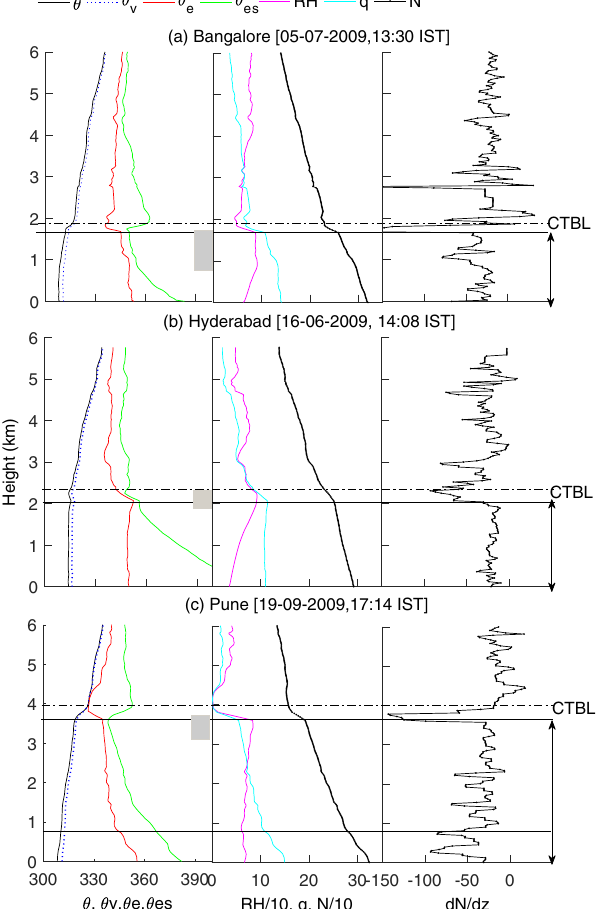
Figure 7. Same as Fig. 4 but observed over (a) Bangalore on 5 July 2009, (b) Hyderabad on 16 June 2009, and (c) Pune on 19 September 2009, indicating the CTBL. The grey rectangular box indicates the cloud layer representing RH > 83%.